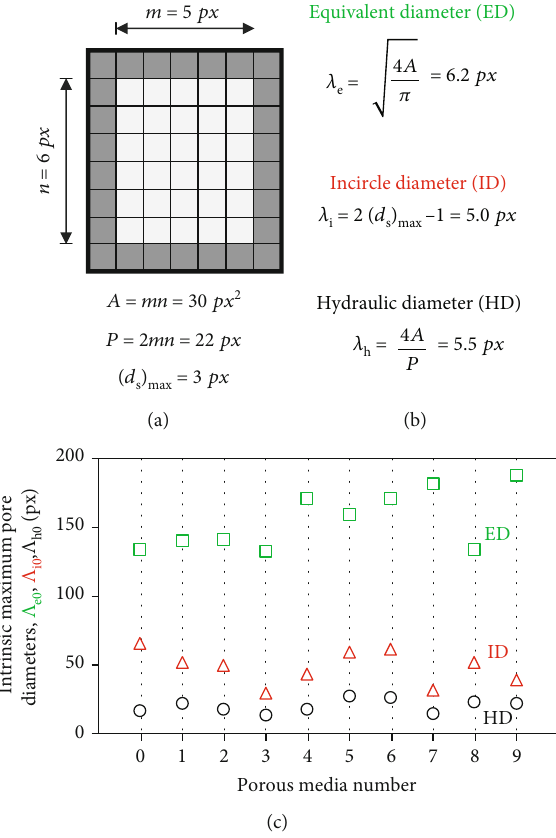
Figure 2: Equivalent, incircle, and hydraulic diameters of fl uid- occupied pores within hydrate-bearing and hydrate-free porous media. (a) A pixel map of a rectangular pore occupied by fl uids within hydrate-bearing porous media. Light gray pixels stand for the fl uid-occupied pore with side lengths of 5 and 6px, while dark gray pixels represent solid particle and hydrate pixels. Area A of the pore is 30 px 2 , and perimeter P is 22px . Symbol d s represents the minimum distances of pore pixels to solid particle and hydrate pixels, and the maximum value ð d s Þ max in the rectangular pore is 3px. (b) Values of equivalent λ e , incircle λ i , and hydraulic λ h diameters for the rectangular pore shown in (a). (c) Values of intrinsic maximum equivalent Λ e0 , incircle Λ i0 , and hydraulic Λ h0 diameters in hydrate-free arti fi cial porous media shown in Figure